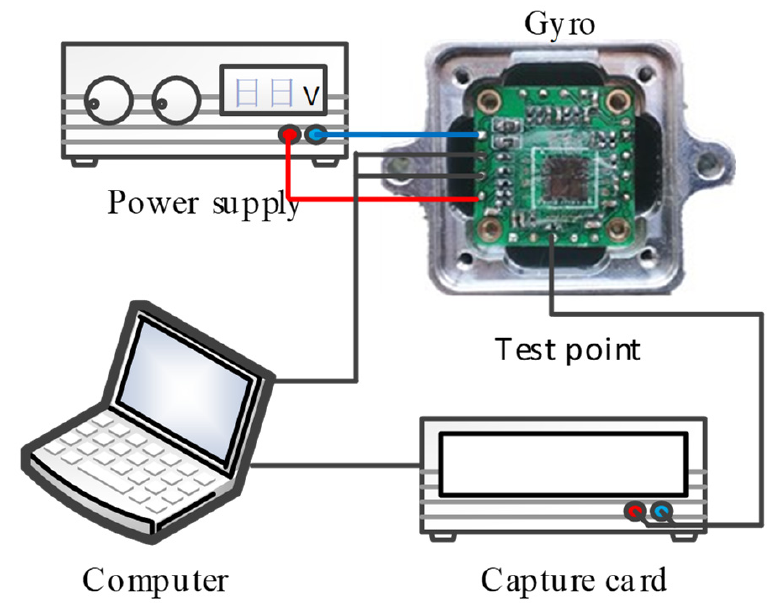
Figure 10. Stability test system for closed-loop controlled drive loop.